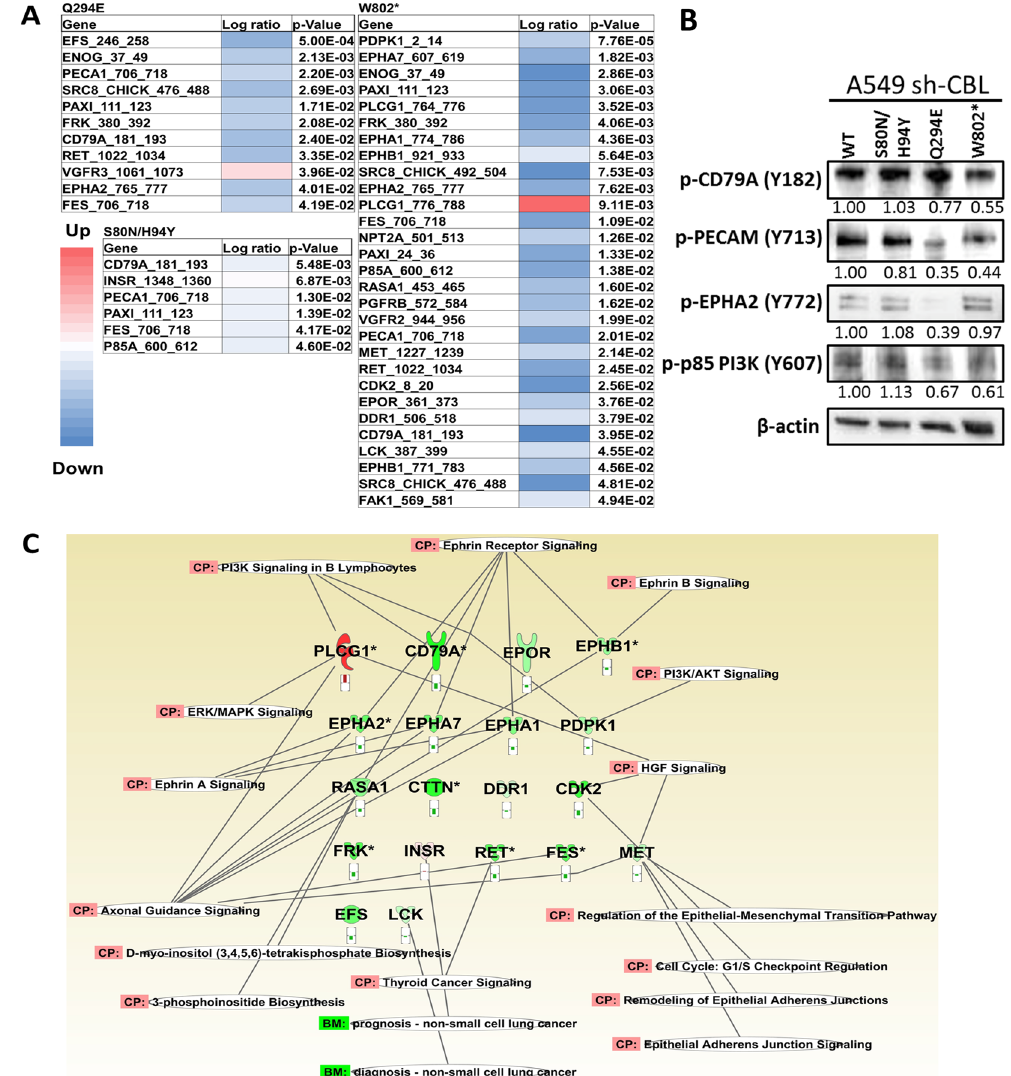
Figure 5. The Heatmap of CBL mutations. ( A ) PamGene analysis was performed to detect the RTK phosphorylation difference between CBL WT and mutants. A549 CBL isogenic cells were treated with MET inhibitor SU11274. After treatment with SU11274, and in comparison with CBL WT, significantly changed peptides were shown as a heatmap. Red color represents the signal upregulation and the blue color represents the signal downregulation. ( B ) The protein expression of common targets in three CBL mutations was validated by immunoblotting. Protein expression was quantified and indicated with the fold change numbers shown below each immunoblot in comparison with WT. Each protein lysates of separated blot of were collected in the same time period for and the lysates were loaded in one gel per antibody staining. ( C) Significantly different peptides were used to analyze affected signaling pathways by Ingenuity Pathway Analysis (IPA). PI3K/AKT, ephrin A, ERK/MAPK, and other signaling pathway were involved especially MET/HGF signaling